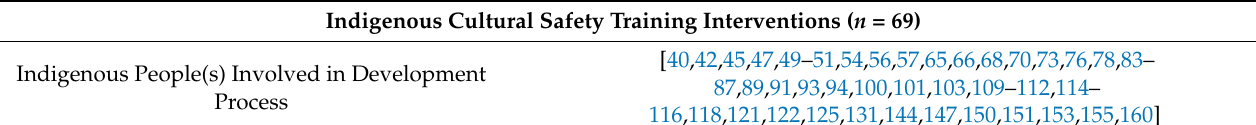
Table A4. Citations for Indigenous Cultural Safety Training